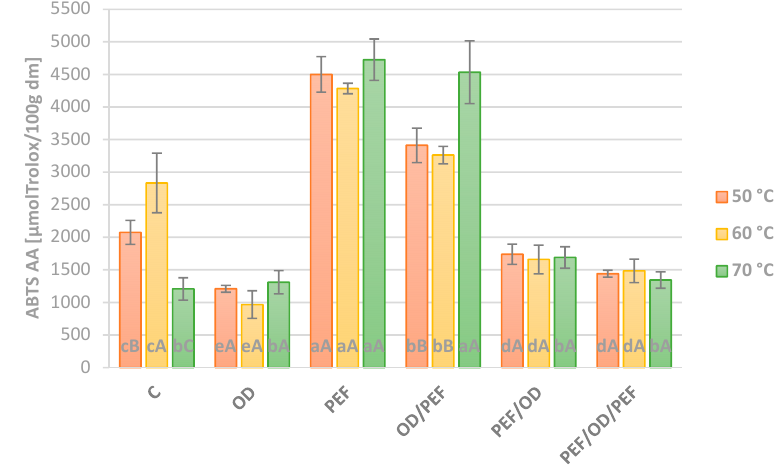
Figure 4. Antioxidant activity (AA) by ABTS assay of untreated and differently pre ‐ treated kiwifruit snacks dried at the temperatures of 50, 60 and 70 °C. Different lowercase letters indicate significant differences ( p < 0.05) between all considered samples at each drying temperature, while capital letters indicate significant differences ( p < 0.05) between each sample at the three drying temperatures.